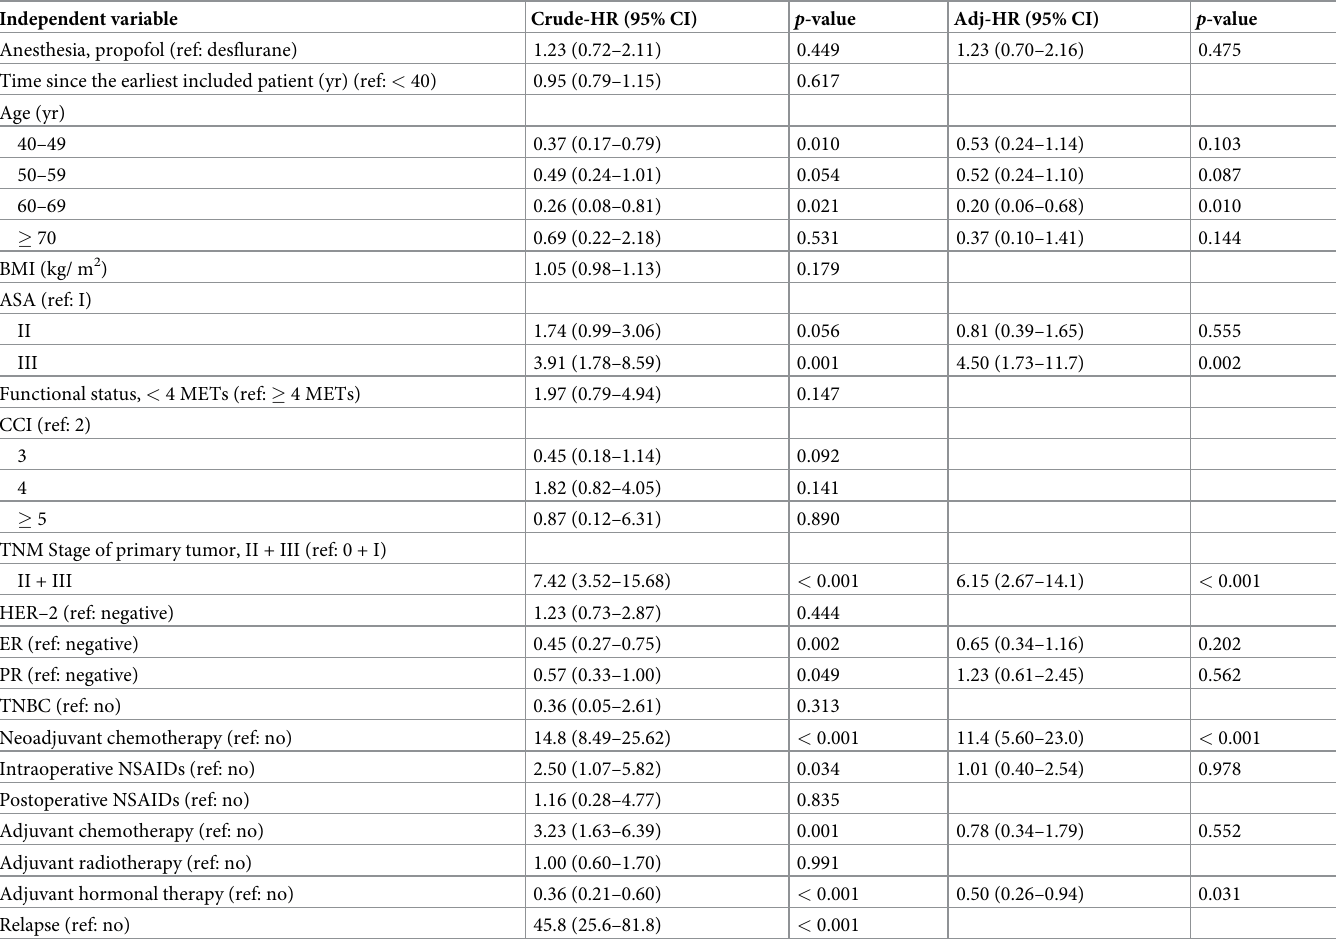
Table 3. Cox regression proportional hazard survival: Univariable and multivariable models for matched patients (n =